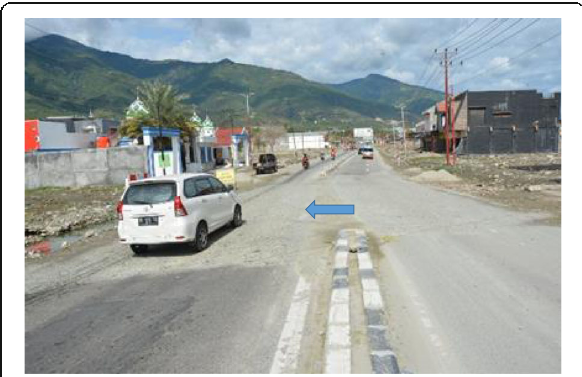
Fig. 4 Large ground displacement of 2.7m at Pangeran Diponegoro street in Palu city